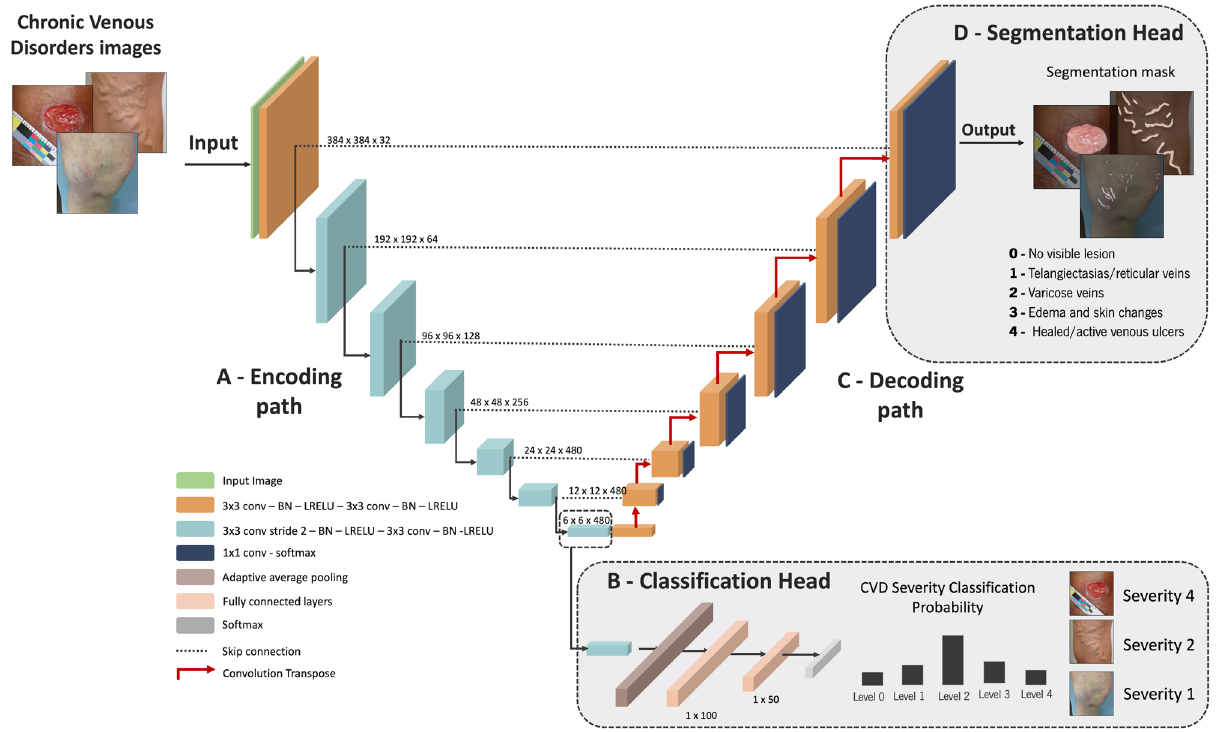
Figure 2. Overview of the proposed VENet for CVD severity classification and lesion segmentation. ( A ) Encoding path; ( B ) Classification head; ( C ) Decoding path; ( D ) Segmentation